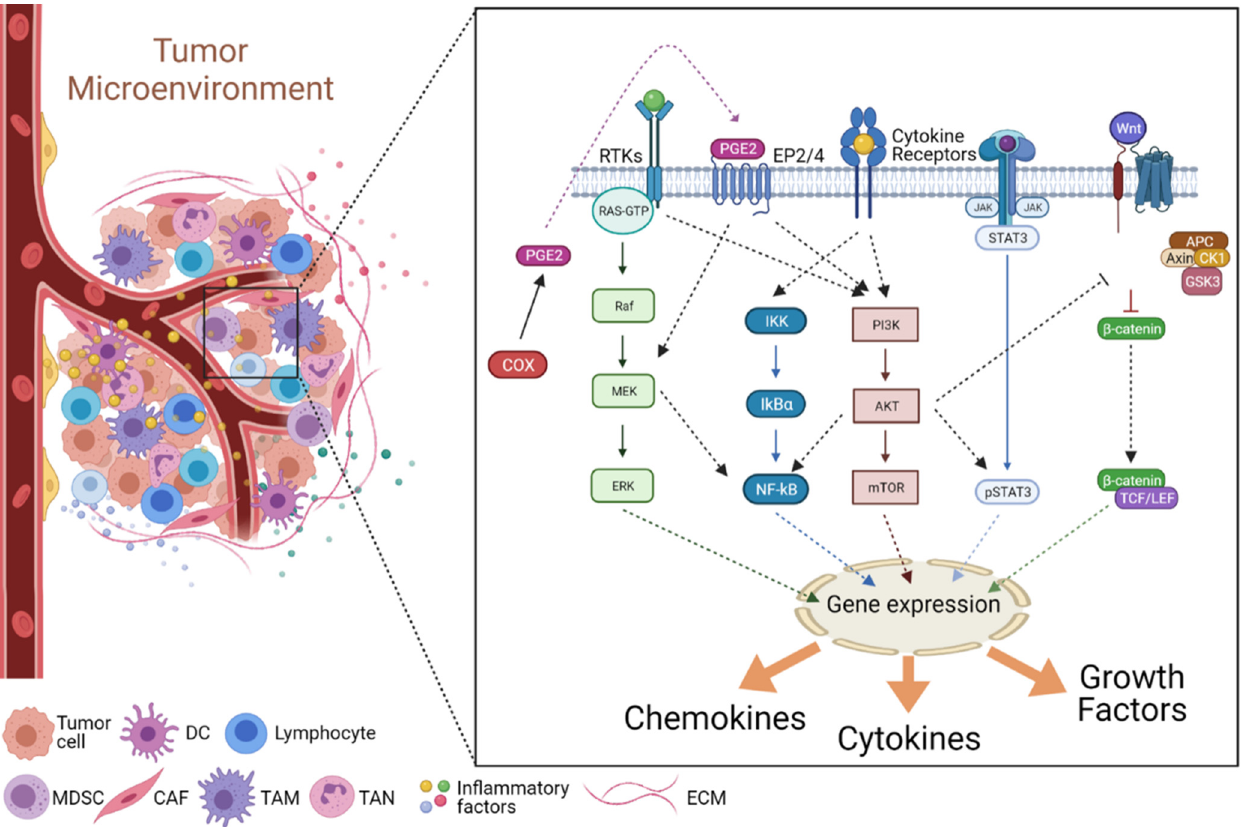
Figure 2. Schematic representation of the signaling pathways that are activated in tumor cells or tumor-associated stromal cells and modulate the interplay within the inflammatory tumor microenvironment, promoting tumor development and progression (see text for details). TAM—tumor-associated macrophage; TAN—tumor-associated neutrophil; DC—dendritic cells; CAF—cancer-associated fibroblast; MDSC—Myeloid-derived suppressor cells; ECM—Extracellular matrix. Figure created with BioRender.com.